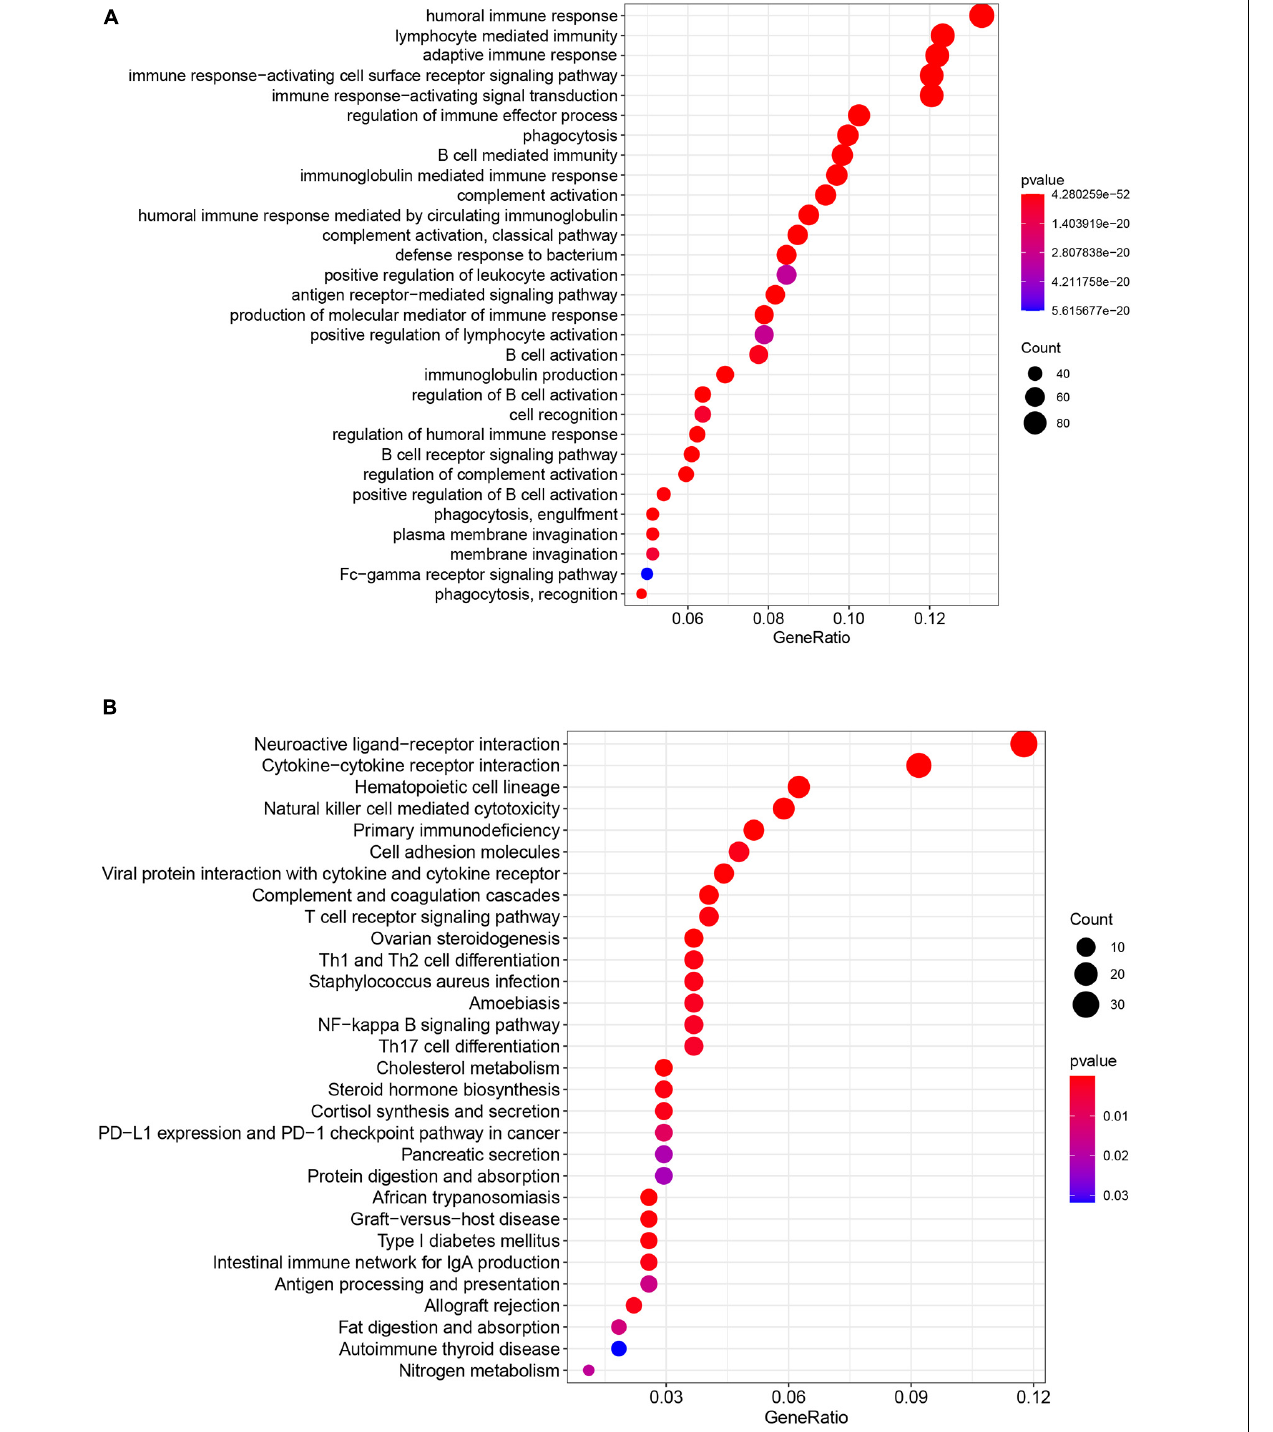
Frontiers in Cell and Developmental Biology |